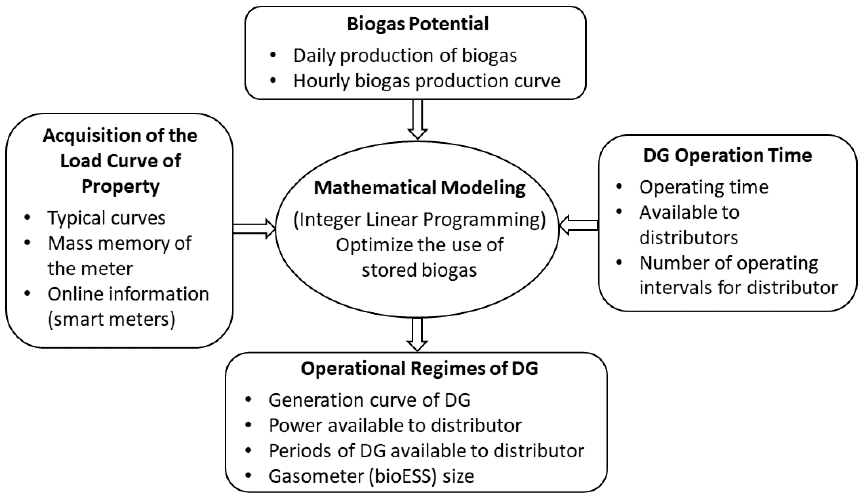
Figure 1. Structuring of the optimization method applied to bioESS to determine MOR for DG.